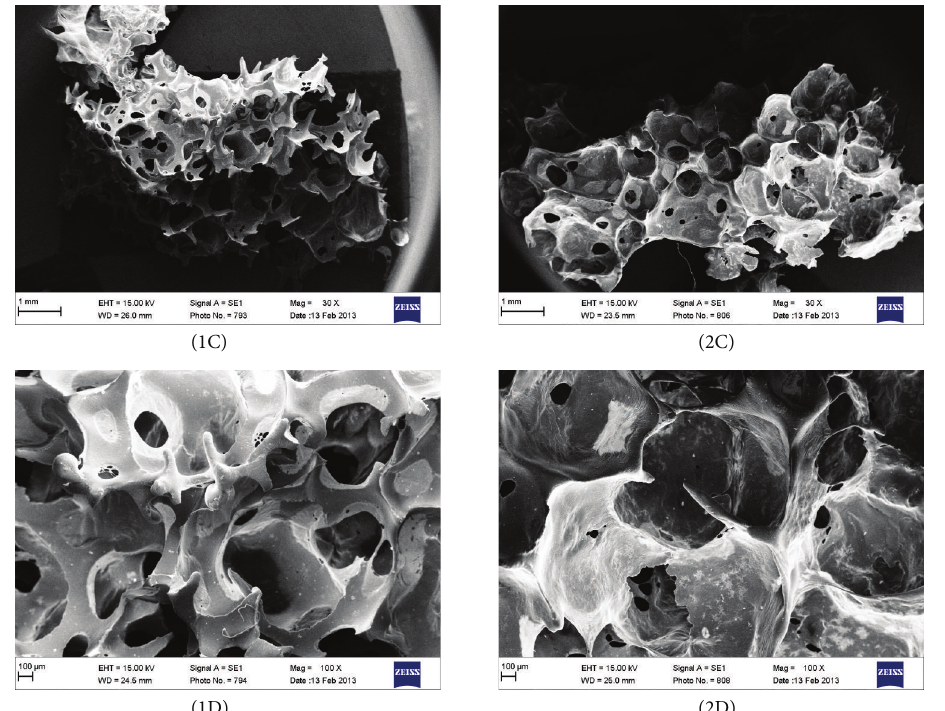
Figure 6: SEM of PU foams, in which chain extender was EHEE, after gelatin modification with 20% of gelatin addition, viewed at × 30 (1C) and × 100 (1D) magnification, and 30% of gelatin addition, viewed at × 30 (2C) and × 100 (2D) magnification.